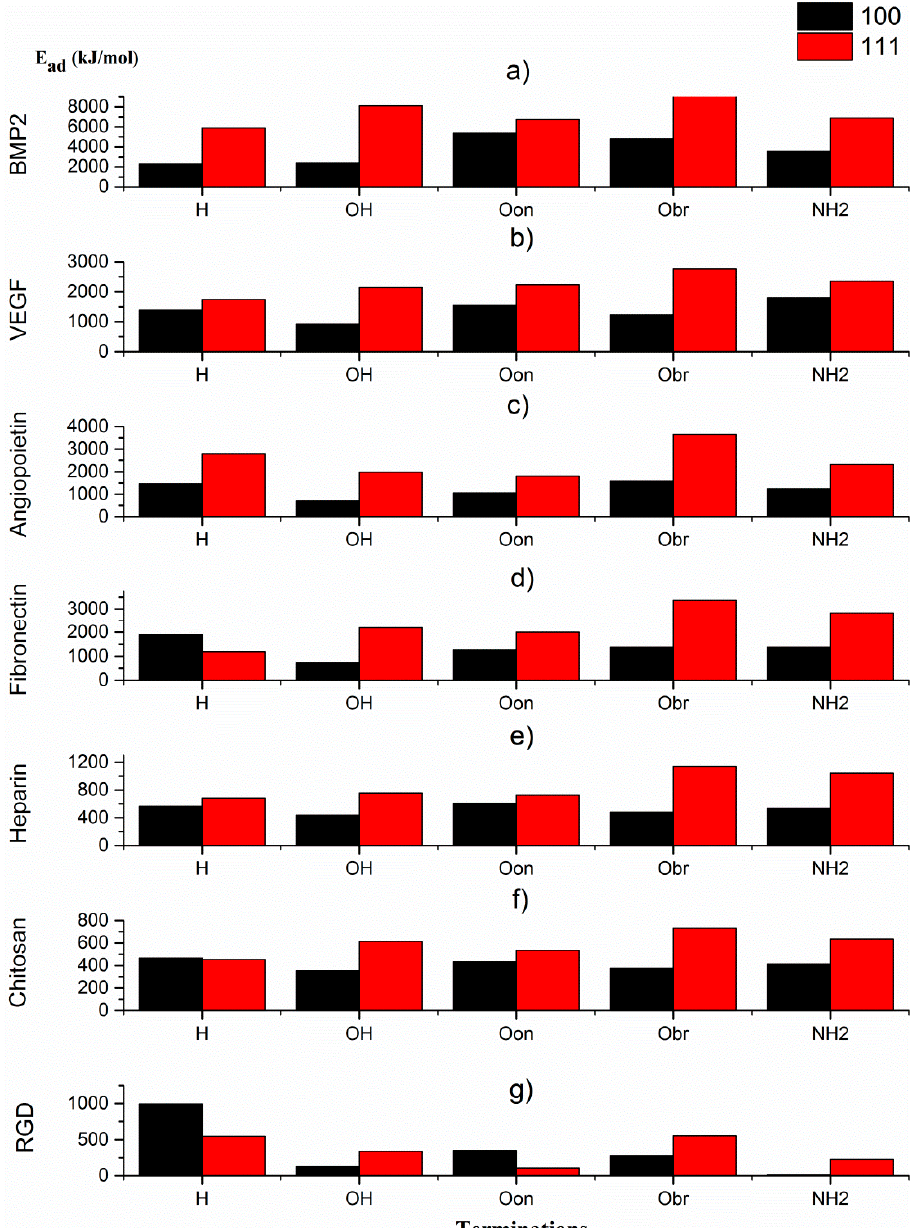
Figure 3. Adhesion energies as a function of surface termination species for seven different biomolecules attached to diamond (111) and (100)-2x1, respectively; ( a ) BMP2, ( b ) VEGF, ( c ) AGP1, ( d ) fibronectin, ( e ) heparin, ( f ) chitosan and ( g ) RGD peptide. The surface terminating species are H, OH, O ontop , O bridge and NH 2 .